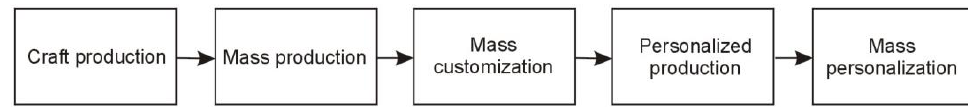
Figure 2. Production paradigm shift [40].